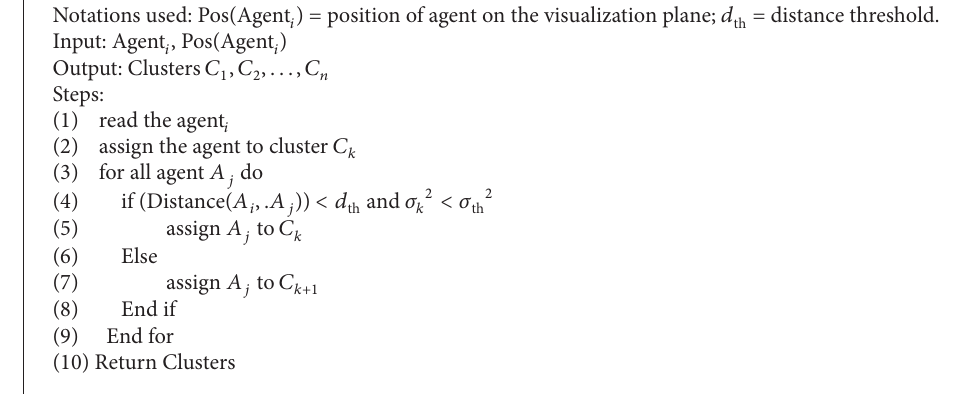
Algorithm 3: Cluster-creation